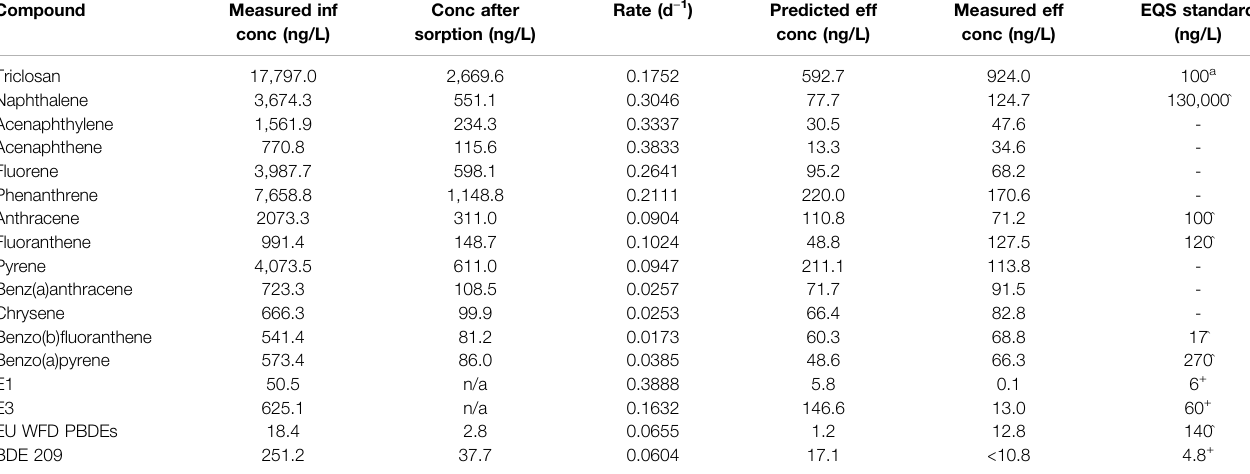
TABLE 4 | Predicted ef fl uent concentration of the chemicals after facultative pond treatment (WSP, Brazil WWTP C). Compound Measured inf conc